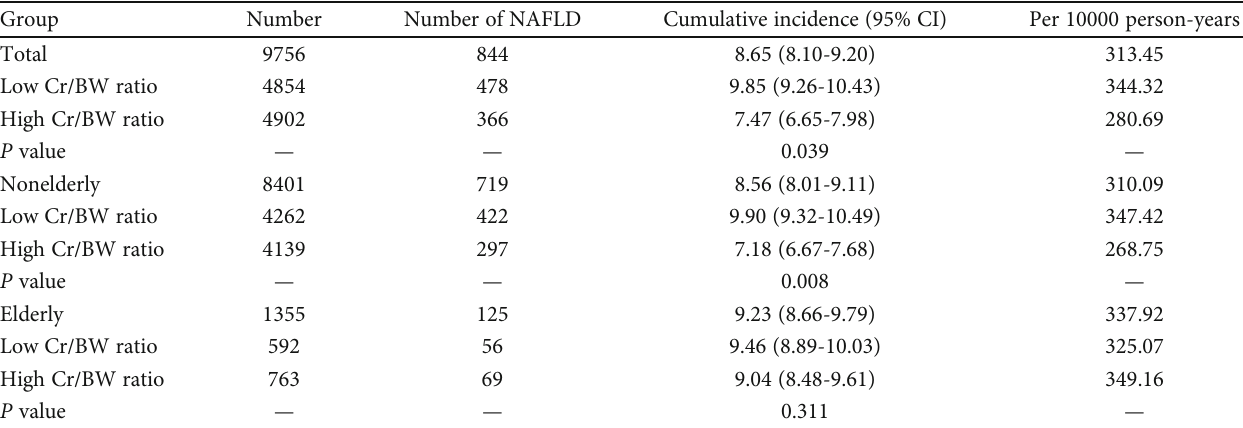
Table 3: Incidence rate of NAFLD of di ff erent